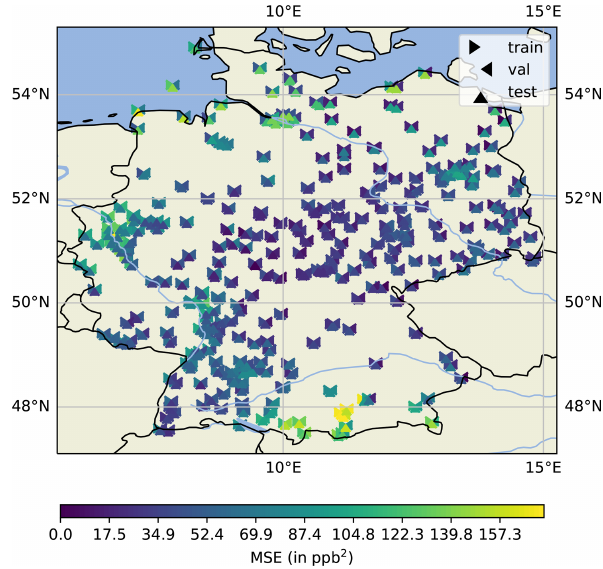
Figure 8. Skill score (NN3s vs. ols) per station for lead times of 1d (a) to 4d (d) . This figure was created with Cartopy (Met Of- fice, 2010–2015). Map data © OpenStreetMap contributors 2022. Distributed under the Open Data Commons Open Database License (ODbL) v1.0.